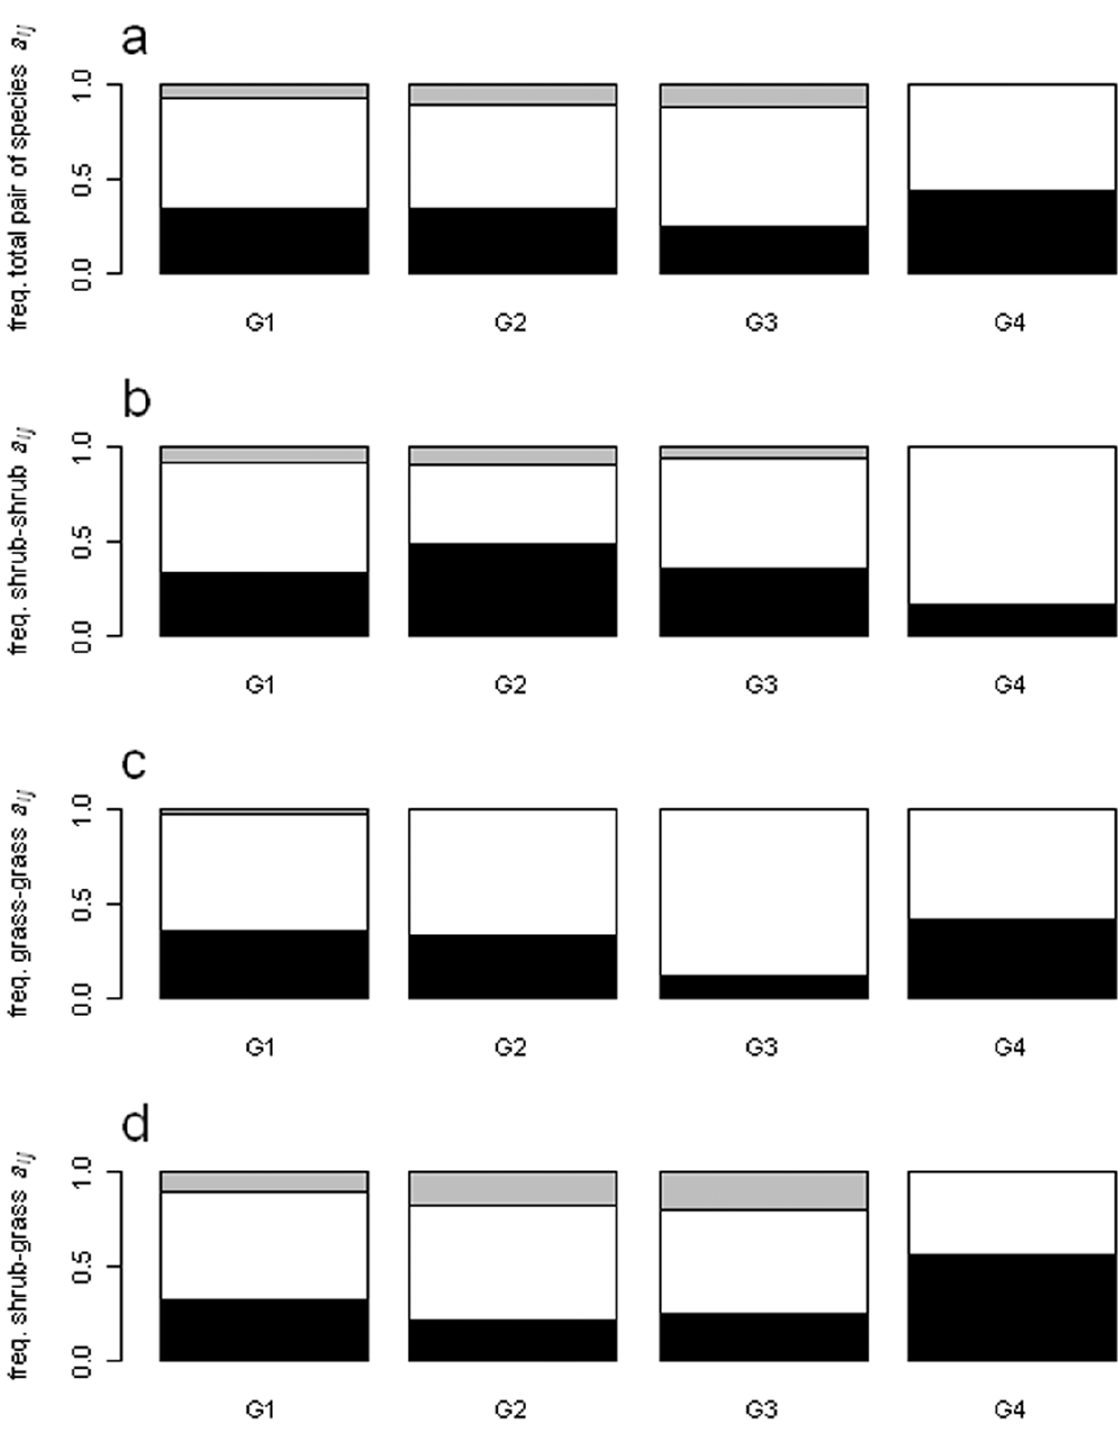
Figure 3. Relative number of pairs of species for each type of association. a, proportion of pairs of species with each type of association; b, proportion of types of association between pairs of shrubs; c, proportion of types of association between pairs of grasses; d, proportion of types of association between pairs of shrubs and grasses. G1 to G4 are the sampling sites. Associations are classified as negative (black area), neutral (white area) or positive (grey area) depending on the relation between a ij value and the expected distribution. Only pairs of species that could allow distinguishing negative associations were employed.